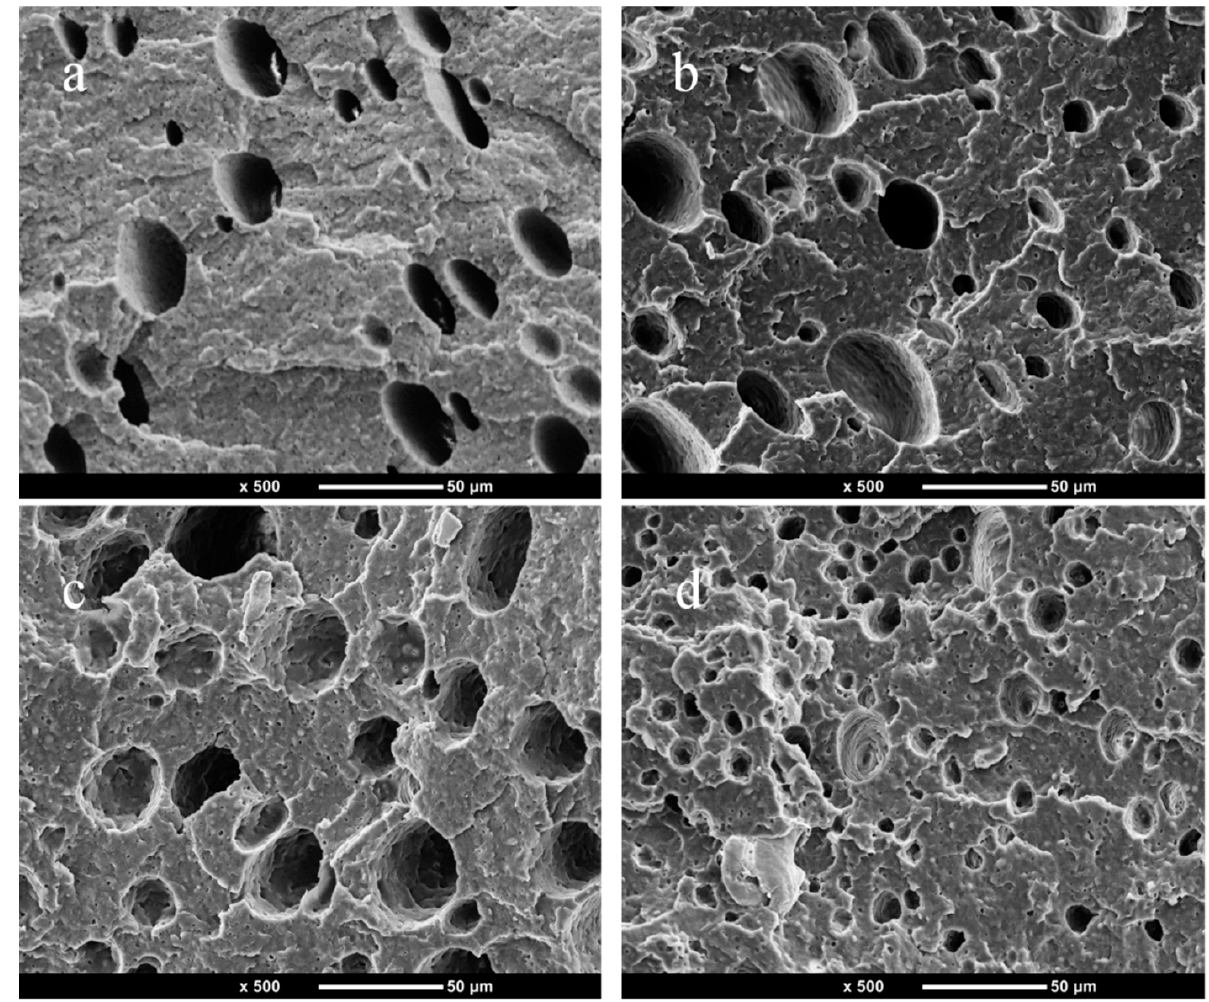
Figure 5. SEM picture of injection molded foam of PP/PTFE composite material with different contents of PTFE ( a ) PP; ( b ) 1% PTFE; ( c ) 3% PTFE; ( d ) 5% PTFE. Figure 6 is the DSC curve of PP/PTFE and PP/PTFE/MWCNTs composites with different contents of PTFE and MWCNTs. Table 4 displays the thermal parameters of